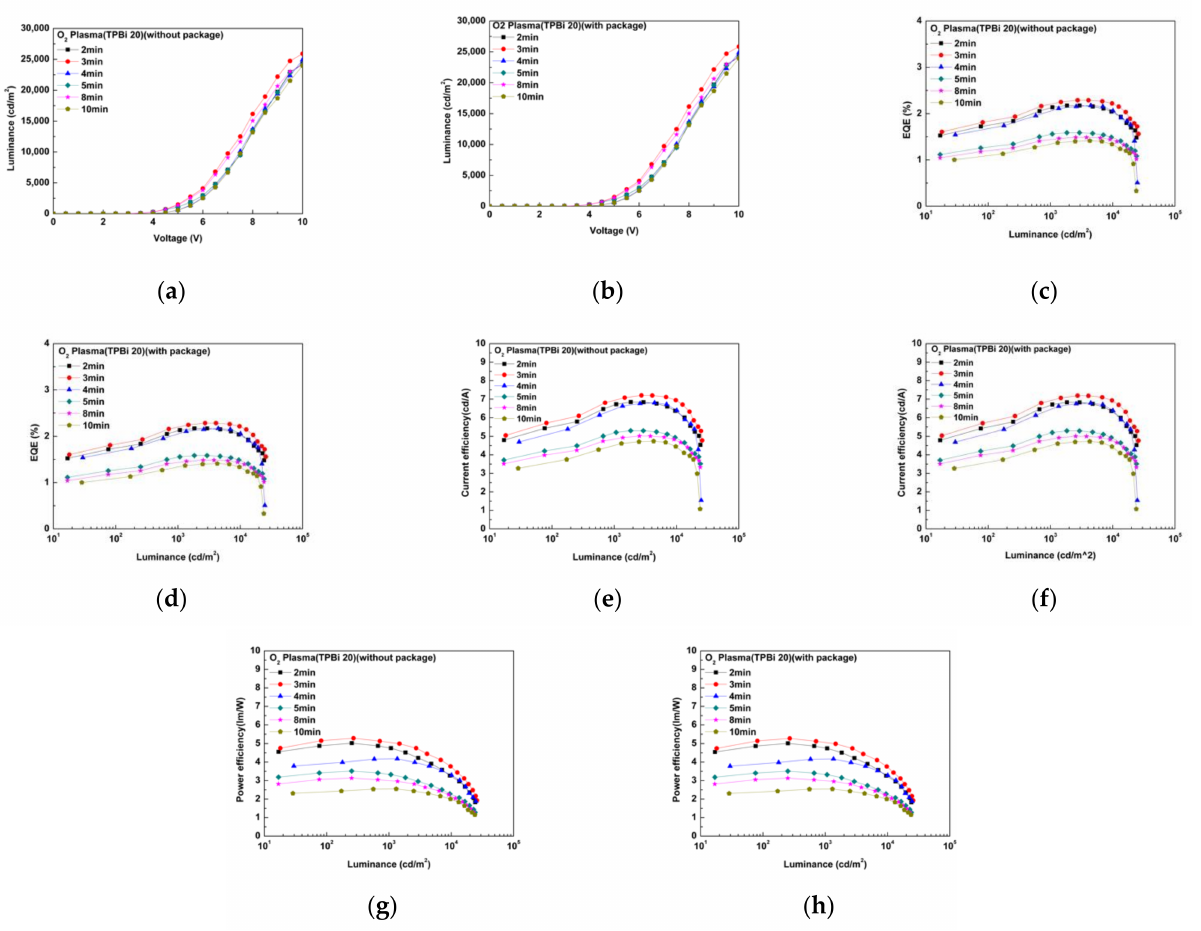
Figure 5. Results under the different oxygen plasma bombardment times for luminance and voltage ( a ) without packaging and ( b ) with packaging; EQE and luminance ( c ) without packaging and ( d ) with packaging; current efficiency and luminance ( e ) without packaging and ( f ) with packaging; and power efficiency and luminance ( g ) without packaging and ( h ) with